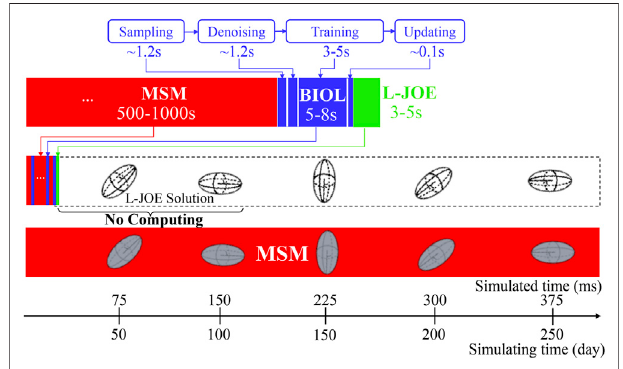
FIGURE 9 | Comparison of overhead using pure MSM and our integrated methods.